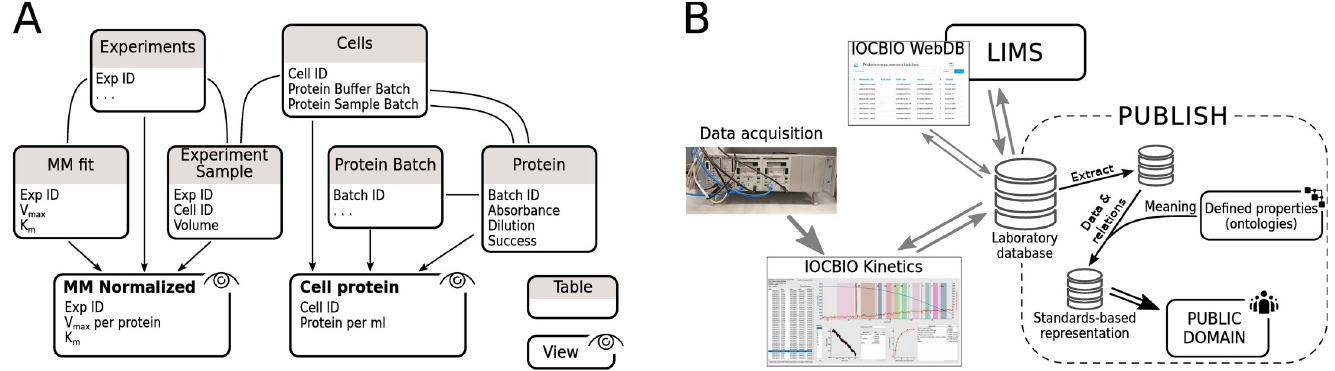
Fig 2. Example analysis pipeline (A) and overall positioning of the software in experimental data processing and publishing (B). In A, database tables are shown as boxes and relations between the tables as lines. Views are formed as shown by the arrows. See main text for description of the example pipeline. In B, the positioning of the released software relative to the laboratory data handling together with the publishing of the data is